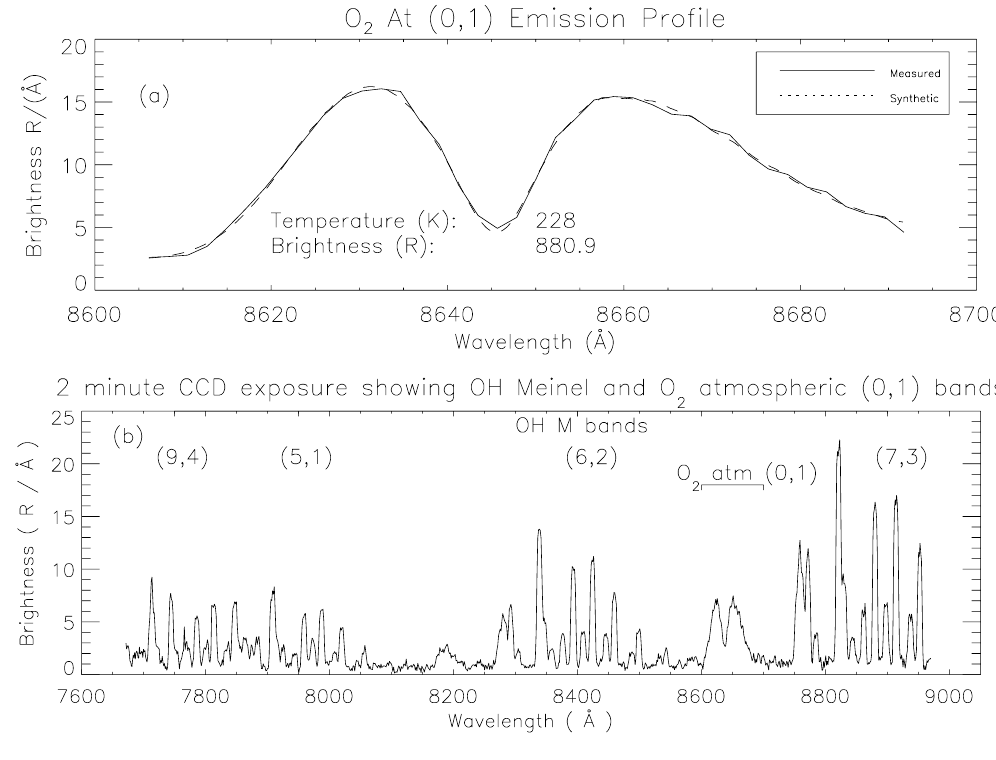
Fig. 2. (a) Measured and fitted O 2 At(0,1) band emission with (b) A typical 2-minuted averaged CCDS spectrum showing various nightglow